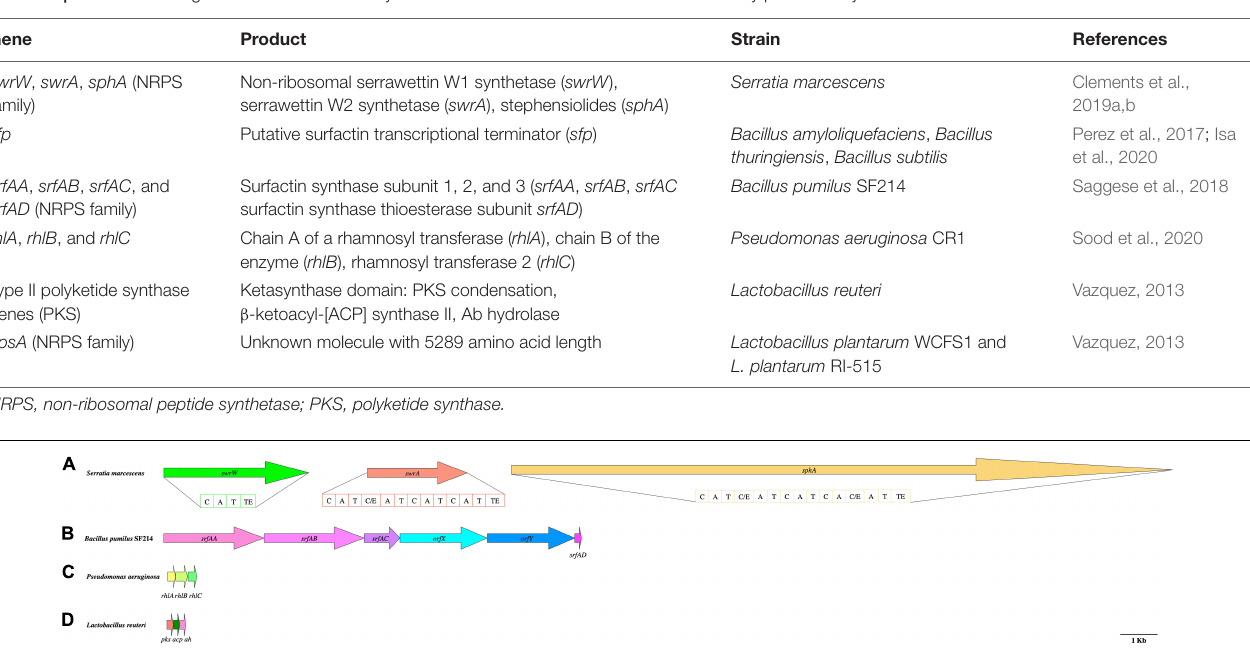
FIGURE 2 | Gene clusters involved in the biosynthesis of biosurfactant with antimicrobial activity. (A) Serrawettin genes from Serratia marcescens — swrW , swrA , and sphA —encoding, respectively, for serrawettin W1, serrawettin W2, and stephensiolide. The gene domains are as follows: C, condensation; A, adenylation; T, thiolation; TE, thioesterase. (B) srf operon [non-ribosomal peptide synthetase (NRPS) family] from Bacillus pumilus SF214— srfAA , srfAB , and srfAC —encoding, respectively, for surfactin synthase subunit 1, 2, and orfX ; orfY encoding for uncharacterized genes; and srfAD encoding for surfactin synthase thioesterase. (C) Rhamnolipid genes from Pseudomonas aeruginosa CR1— rhlA , rhlB , and rhlC —encoding, respectively, for chain A of a rhamnosyl transferase, chain B of the enzyme, and rhamnosyl transferase 2. (D) Type II polyketide synthase genes (PKS) from Lactobacillus reuteri — pks , acp , and ah genes—encoding for PKS condensation, β -ketoacyl-[ACP] synthase II, and Ab hydrolase,